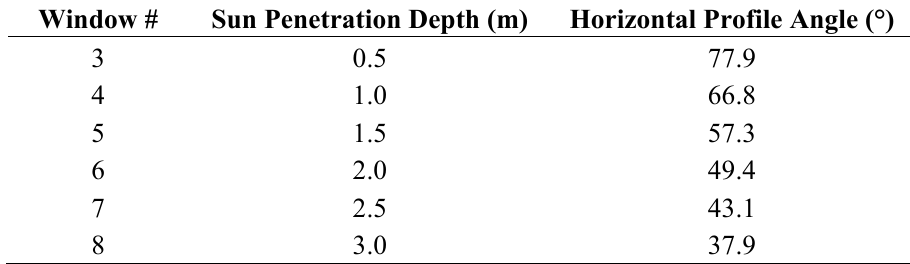
Table 3. Trigger values for manual blind control algorithm (Blindswitch